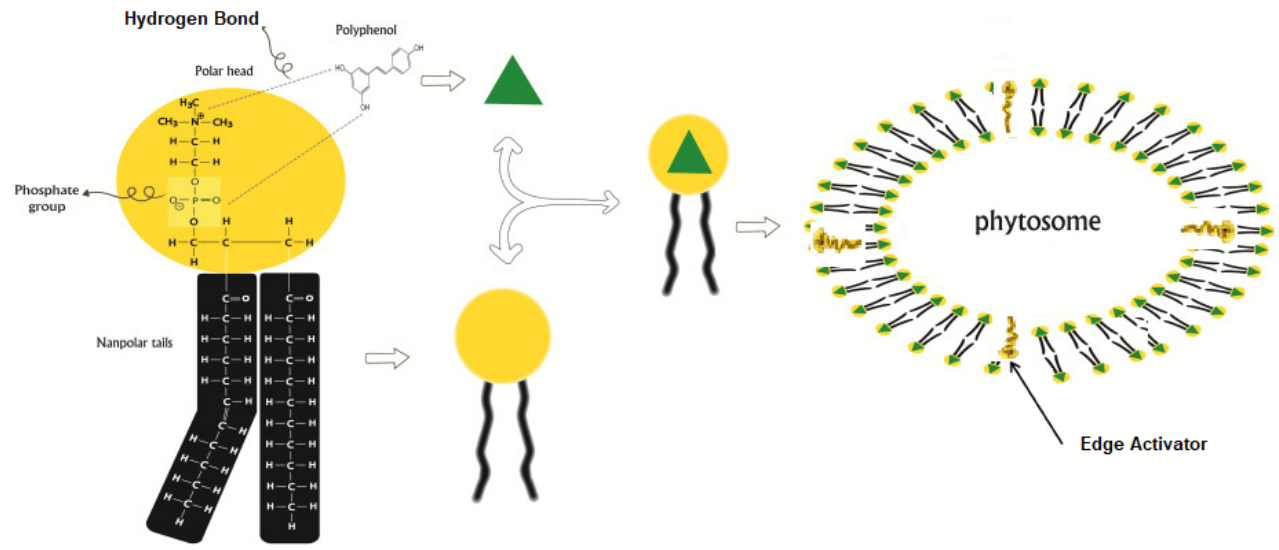
Figure 8. Pictorial representation of phytosome formation. (Adopted from [121] with permission from Frontiers in accordance with the Creative Commons Attribution License).